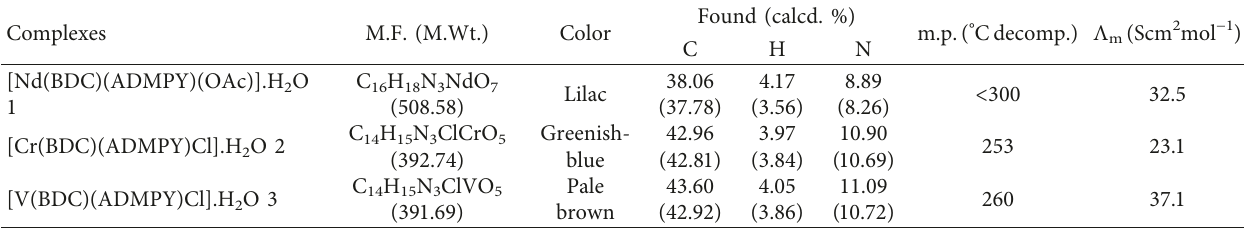
Table 2: Color, elemental analysis, and decomposition point of the mixed ligand complexes. Complexes